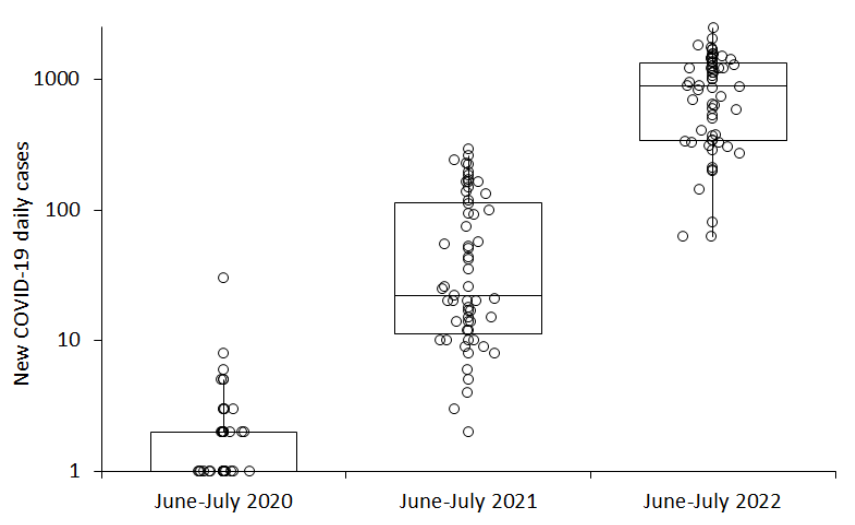
Figure 2. Number of new coronavirus disease 2019 (COVID-19) daily cases recorded in the province of Verona in June–July of the years 2020, 2021, and 2022. Results are presented as median and interquartile range (IQR).